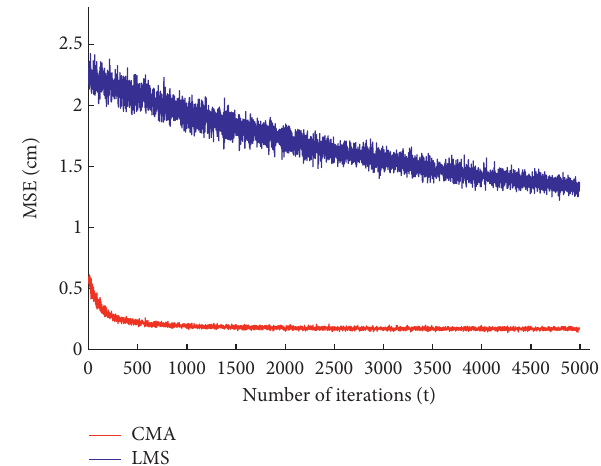
Figure 4: Convergence curves obtained for the CMA and LMS